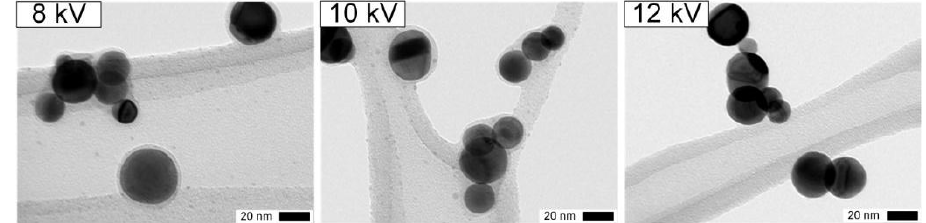
Figure 5. Transmission electron microscopy (TEM) micrograph of final solid coating of nanoparticles for different applied voltage ( U pp ): ( left ) 8 kV; ( middle ) 10 kV; and ( right ): 12 kV, for 0.4 ppmv TEOS and t Reaction = 185 s.